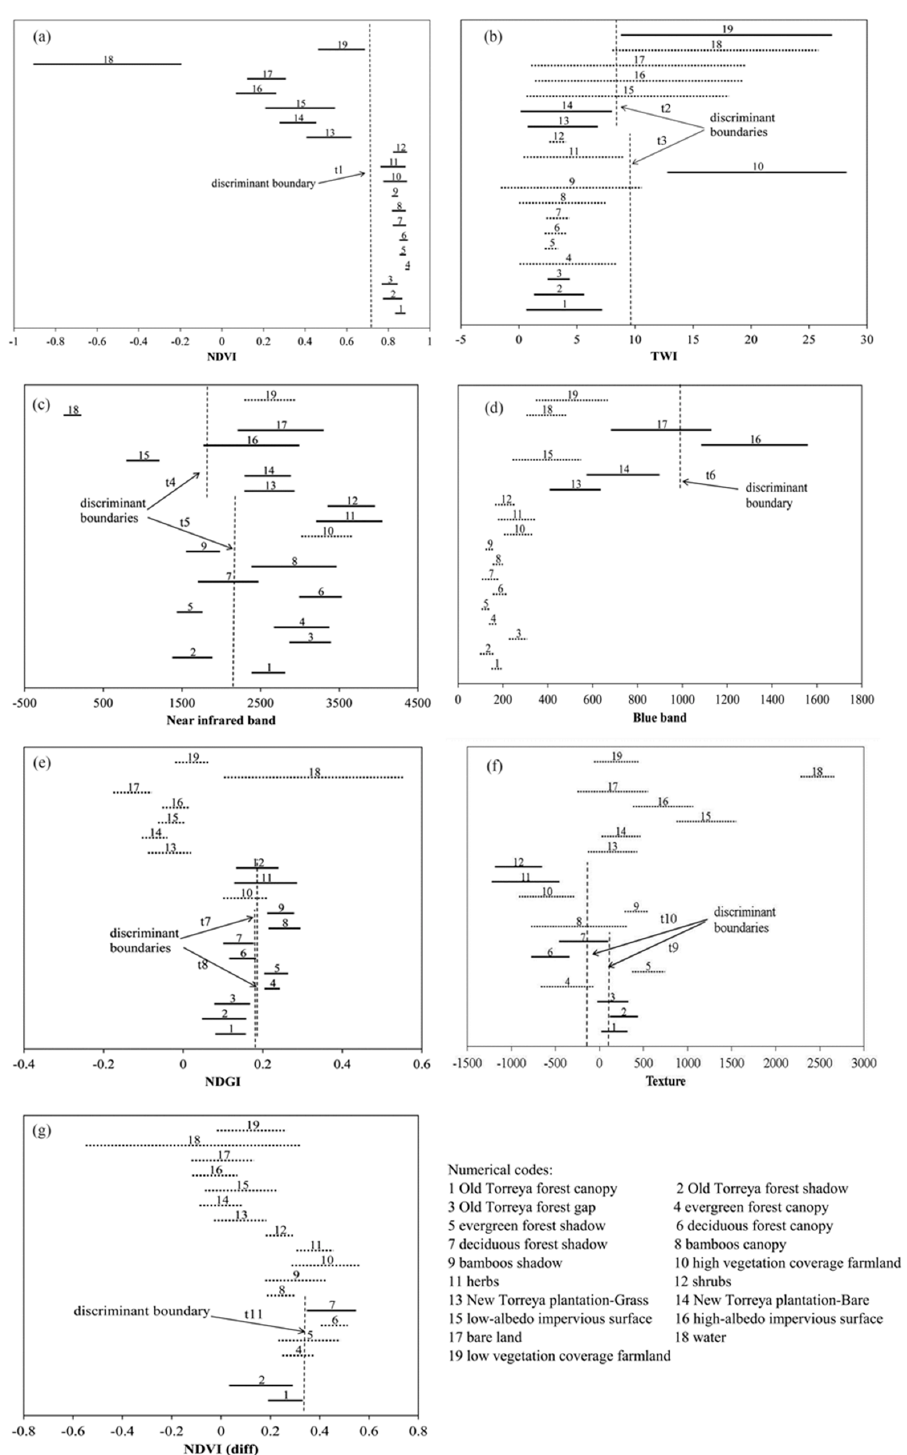
Figure 6. Analysis of variables based on different land covers for determination of thresholds to extract old Torreya forests and new Torreya plantations (Note: the subfigures show the potential discriminant boundaries between the land covers based on NDVI (normalized difference vegetation index) ( a ); TWI (topographic wetness index) ( b ); near infrared band ( c ); Blue band ( d ); NDGI (normalized difference greenness index) ( e ); texture ( f ); and NDVI(diff) (the difference of NDVI images between GF-1 and ZY-3 data) ( g )).